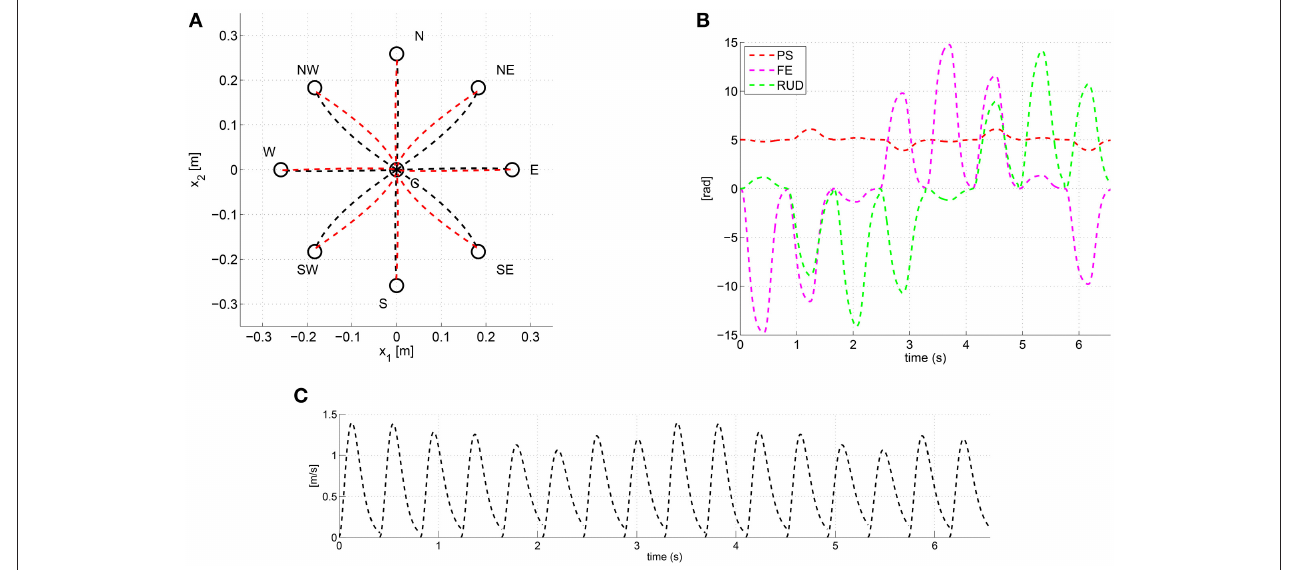
FIGURE 3 | Task space paths (A) , joint trajectories (B) and task-space tangential velocity profiles (C) predicted via the λ 0 -PMP with the anisotropic damping W of Equation (9).